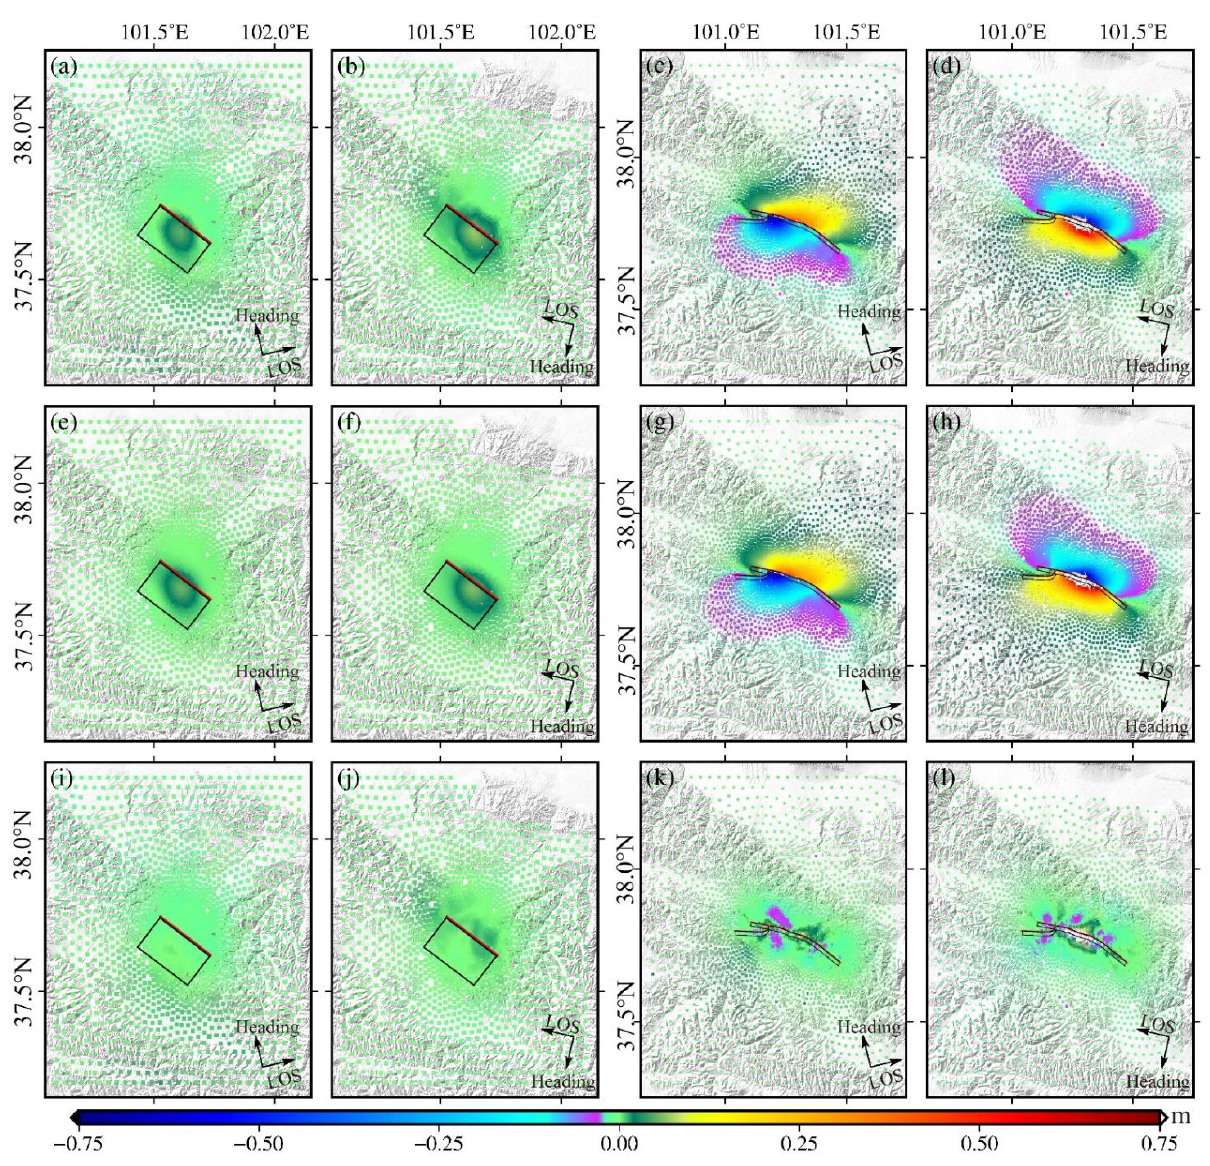
Figure 8. ( a , b ) Observations, ( e , f ) predictions, ( i , j ) residuals from the NLLLF model of the 2016 event on the ascending and descending tracks, respectively. ( c , d ) Observations, ( g , h ) predictions, ( k , l ) residuals from the two-fault model of the 2022 event. The solid red line marks the surface projections of the up-dip edge of the fault model. The black rectangle indicates the surface projection of the upper wall of the fault model.